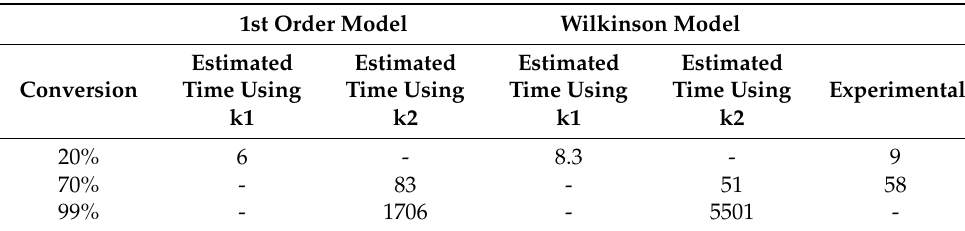
Table 3. Calculation of the biodegradation time (days) corresponding to the conversion of 20 and 70% of the material in comparison with the experimental datum. 1st Order